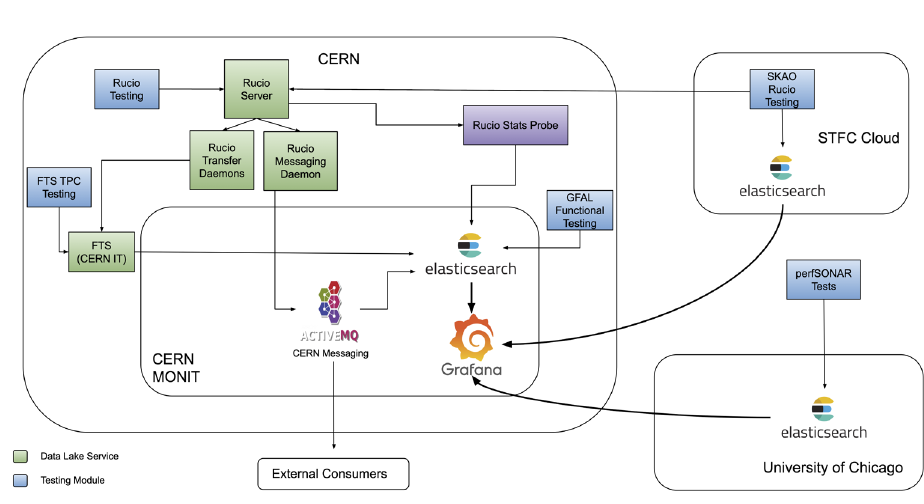
Figure 2: The Data Lake monitoring